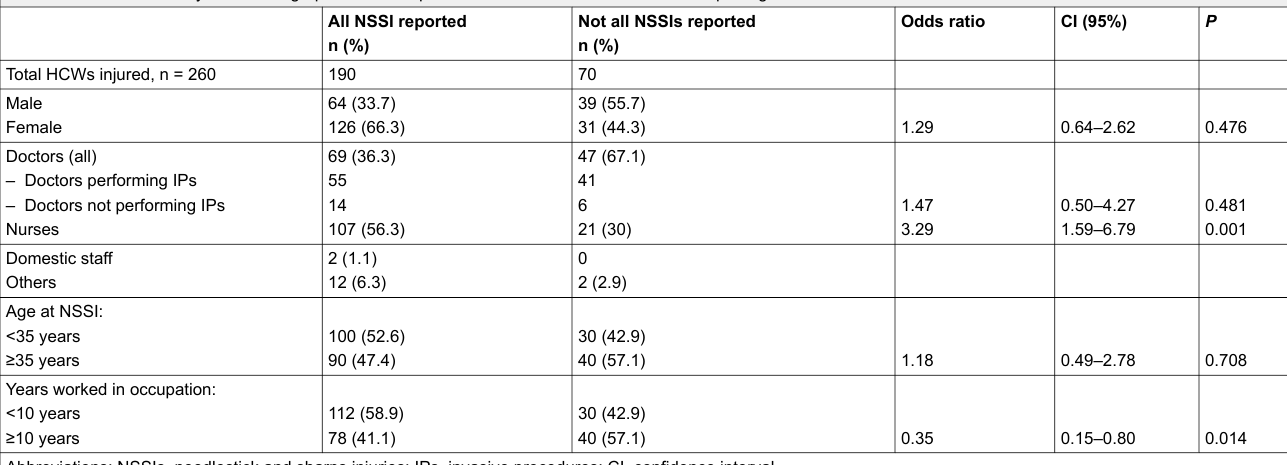
Table 4: Multivariate analysis of demographic and occupational factors associated with underreporting.